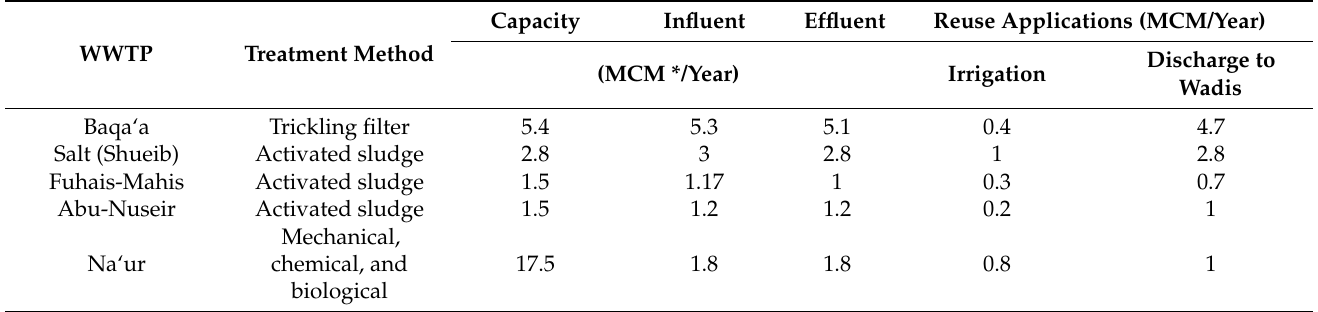
Table 3. Characteristics of the studied wastewater treatment plants and their operation conditions and reuse applications